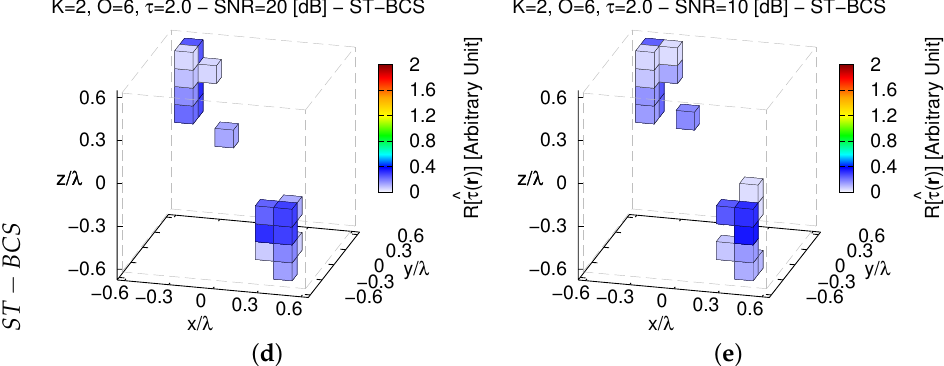
Figure 15. Comparative Assessment ( K = 2, O = 6, τ = 2.0)—( a ) Actual contrast function and retrieved solutions by the ( b , c ) MT-BCS and ( d , e ) ST-BCS when processing noisy data at ( b , d ) SNR = 20 [dB]